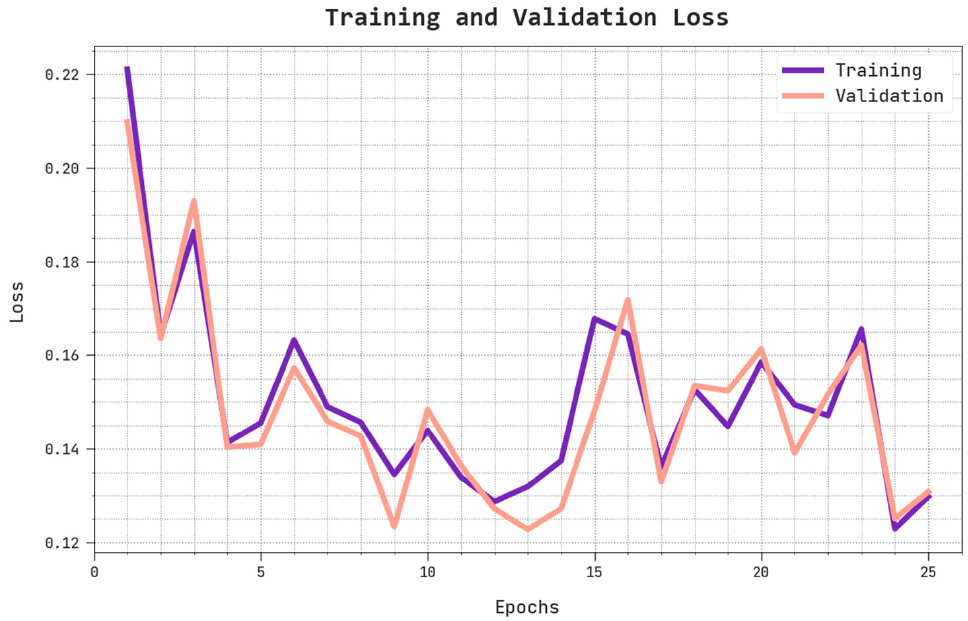
Figure 7. TLS and VLS analysis of IMFL-IDSCS system.